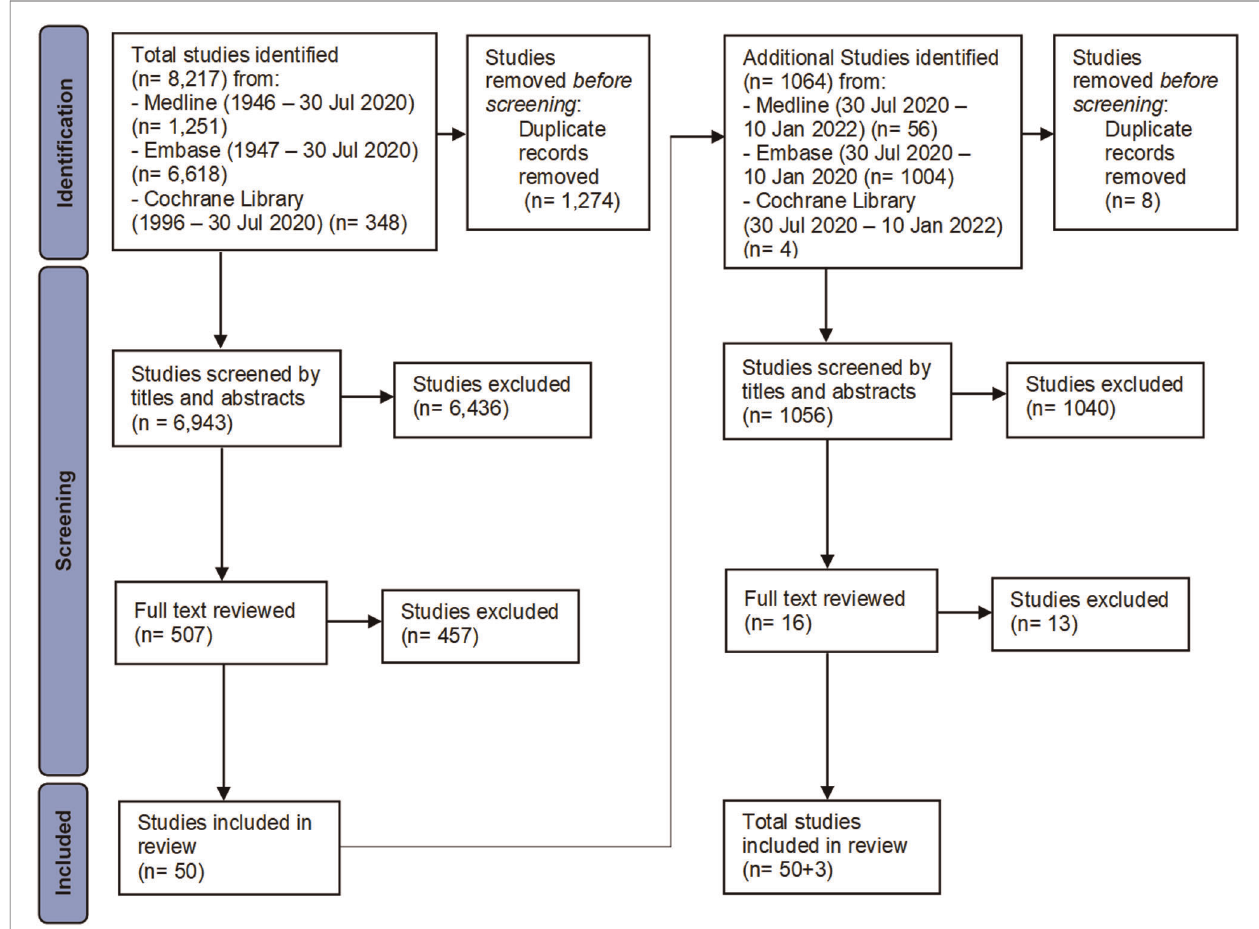
FIGURE 1 | The fl ow chart shows the details of the inclusion and exclusion of manuscripts for